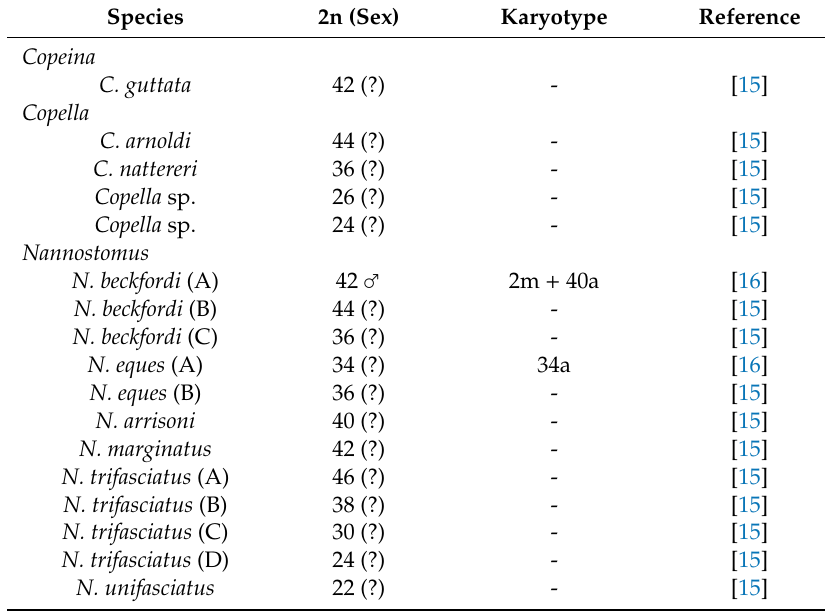
Table 1. Chromosomal data for the Lebiasinidae family. The symbol males and for the females. The question mark (?) was used when the sexes ere not identifiable. The ♀ karyotype formula uses “m” as metacentric, “sm” as submetacentric, “st” as subtelocentric and “a” as acrocentric